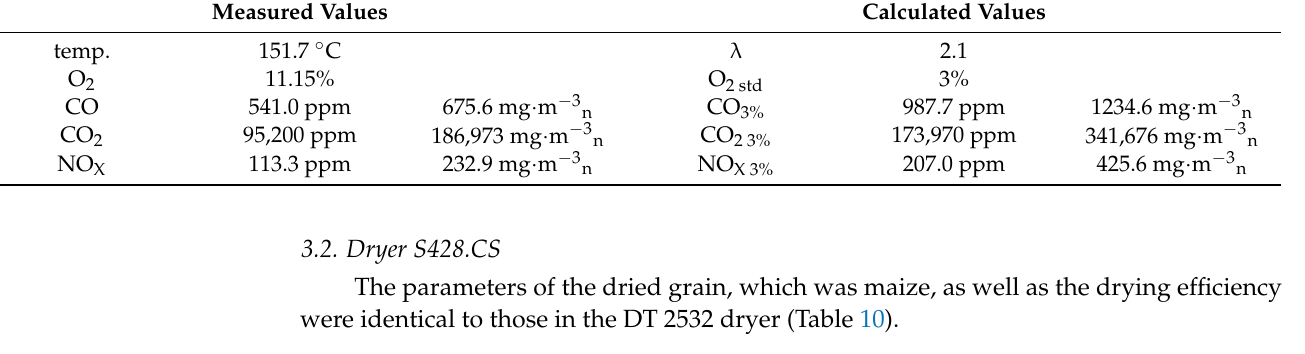
Table 9. Results of measurements of the flue gas composition in the coal furnace of the DT2532 dryer calculated on oxygen content of 3%. Measured Values Calculated Values temp.